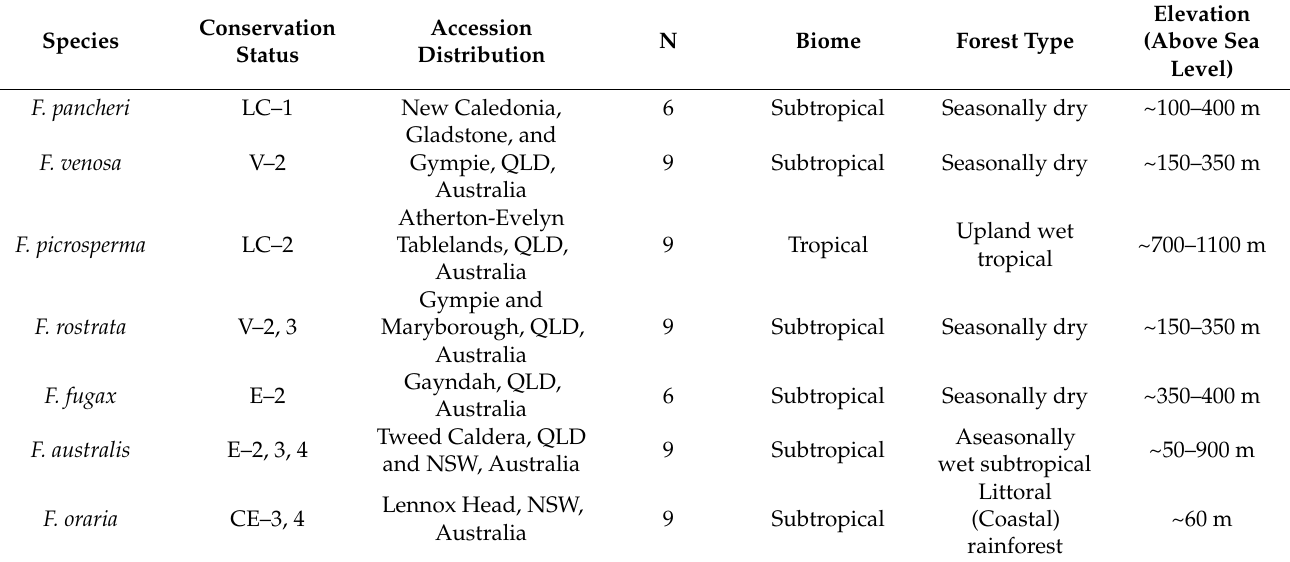
Table 1. List of Fontainea species, geographical distribution, and sampling information used for cpDNA and reduced-representation SNP